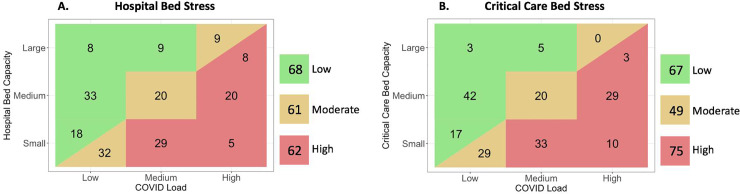
Low, moderate and high Hospital Bed Stress (A) and Critical Care Bed Stress (B), derived from the COVID-19 Load compared to the hospital and critical care bed capacities respectively. Centers with low hospital or critical care bed capacity and no COVID patients were determined to have a low stress, whereas similarly sized centers caring for <20 patients deemed at moderate stress. Centers with high hospital or critical care bed capacity and greater than 200 COVID patients were determined to have a high stress, whereas similarly sized centers caring for <200 patients deemed at moderate stress.